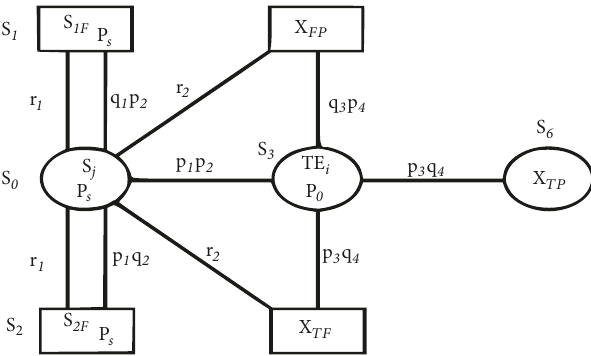
Figure 6: Reliability model for phytoremediation treatment of textile effluent by C. vulgaris